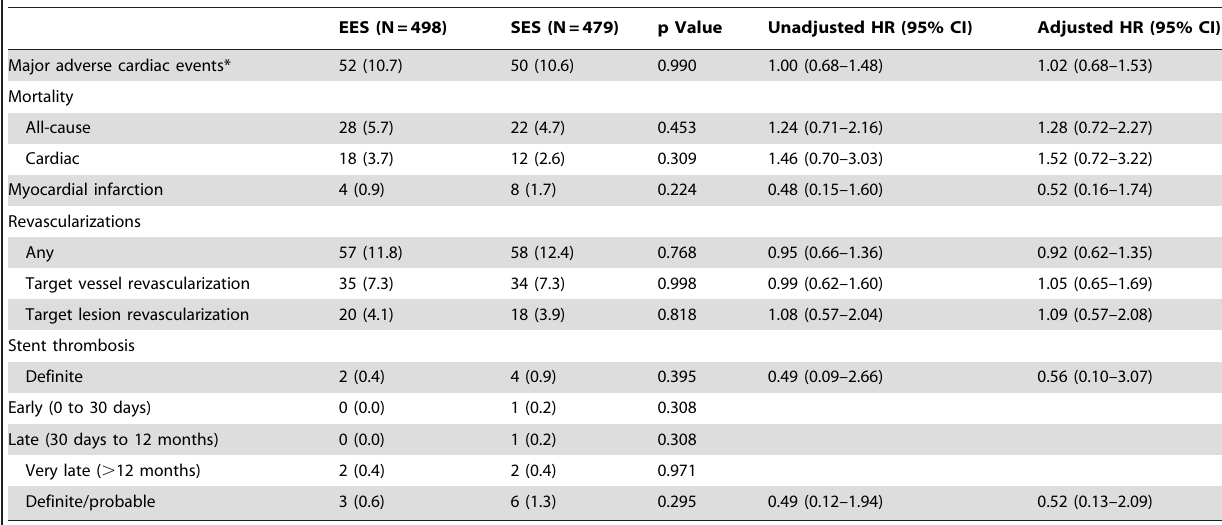
Table 3. Clinical outcomes at 2